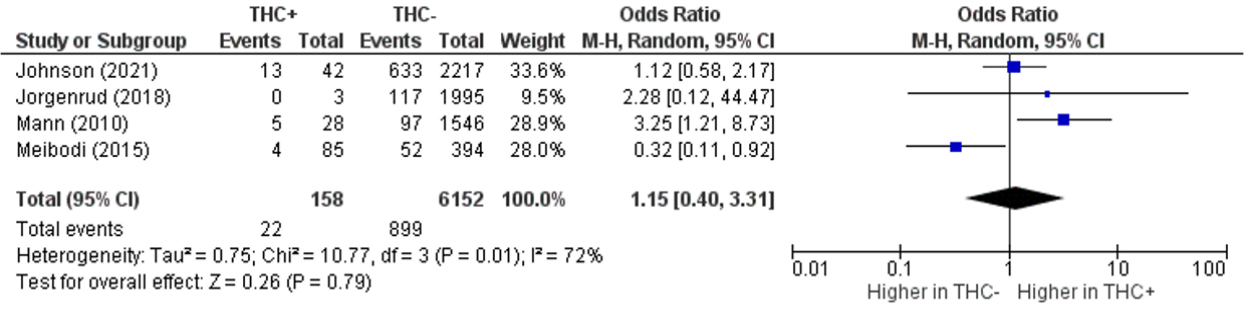
Figure 2. Pooled odds ratio (95% CI) of motor vehicle collision (MVC) risk associated with THC exposure in older drivers over the age of 50 [29,31 – 33].